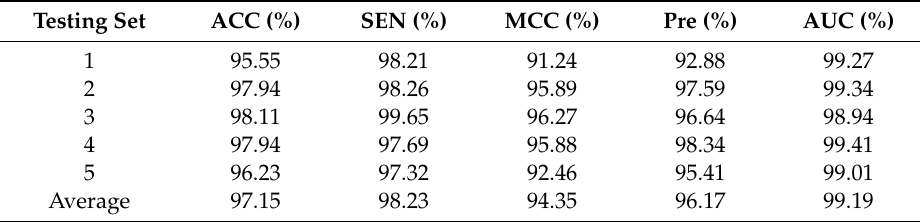
Table 2. five-fold cross-validation results on the H. pylori data set.